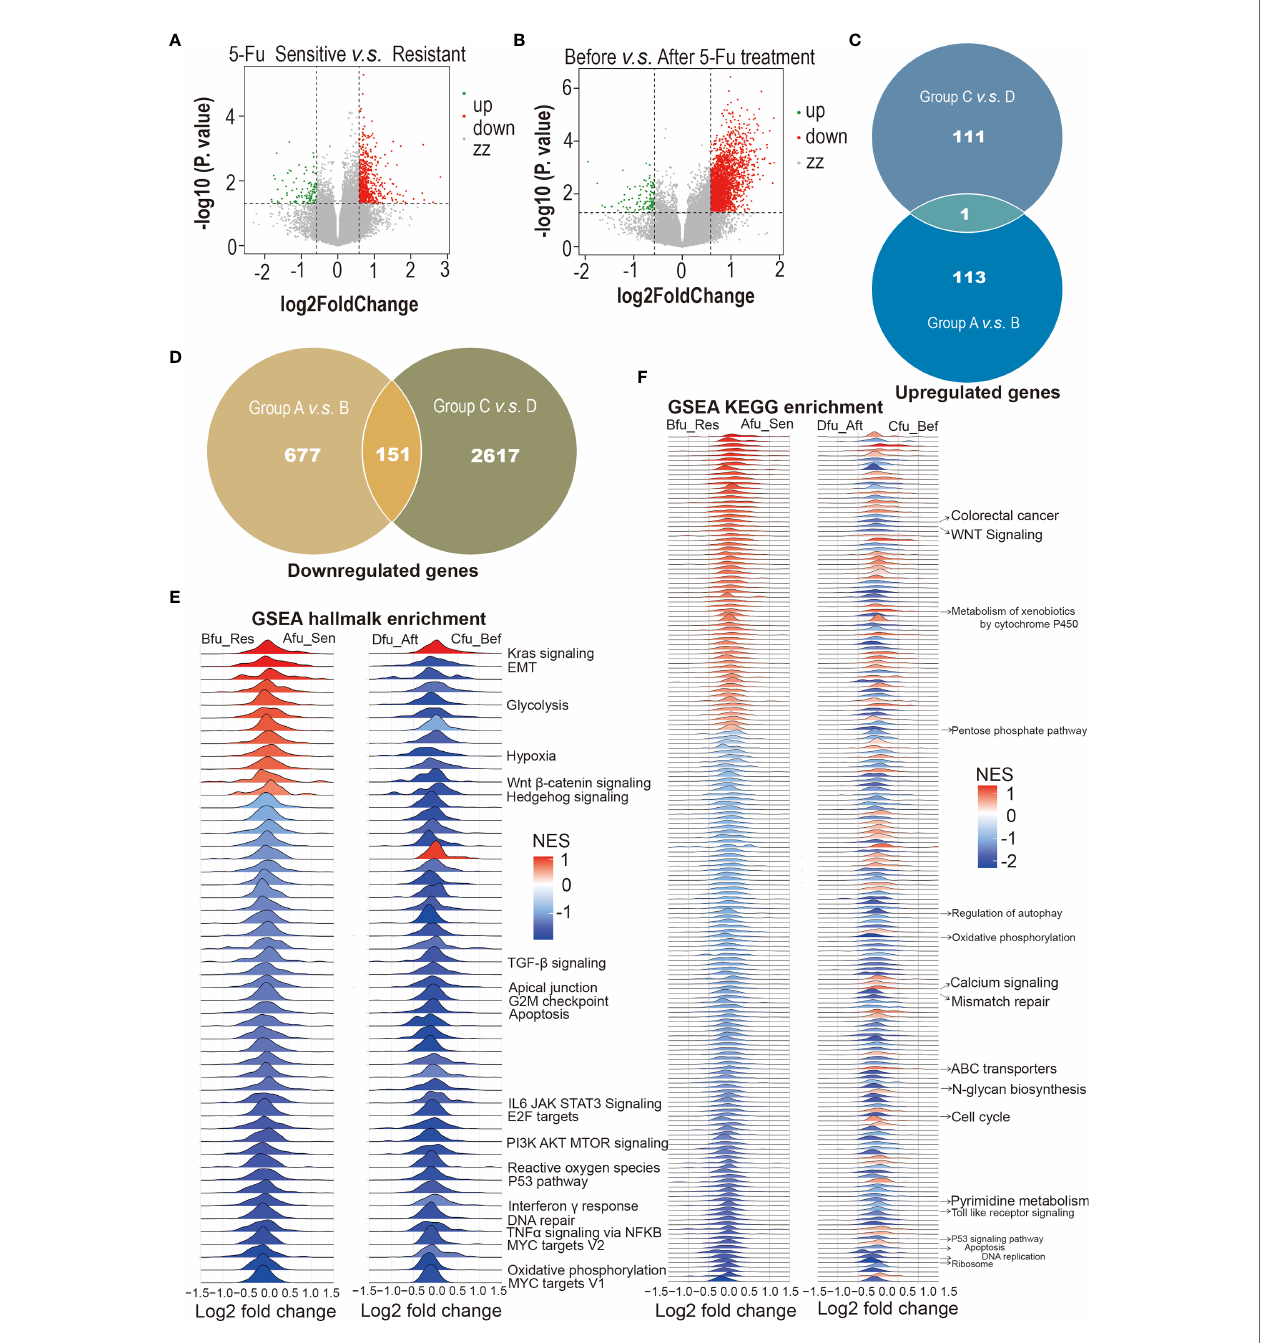
FIGURE 3 | 5-Fu-resistant molecular characteristics of colorectal cancer organoids (CRCOs). (A) Volcano plot for differentially expressed genes between 5-Fu-sensitive (group A) and -resistant (group B) untreated CRCOs. (B) Volcano plot for differentially expressed genes between CRCOs before 5-Fu treatment (group C) and surviving CRCOs after 5-Fu treatment (group D). (C) Venn diagram showed that only 1 upregulated gene was overlapped in the two comparison groups. (D) Venn diagram showed that 151 downregulated genes were overlapped in the two comparison groups. (E, F) Gene set enrichment analysis (GSEA) using the hallmark and KEGG gene sets to dissect the pathways associated with 5-Fu resistance, respectively. The pathways that have been validated in literature were marked. 5-Fu, 5- fl uorouracil; GSEA, gene set enrichment analysis; Res, resistant; Sen, sensitive; Aft, after; Bef, before; NES, normalized enrichment score; KEGG, kyoto encyclopedia of genes and genomes; CRCOs, colorectal cancer